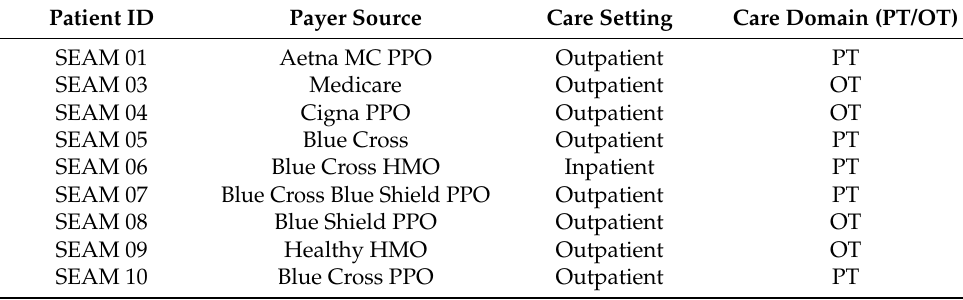
Table 3. Participants’ ( n = 9) payer sources, care setting, and care domain.